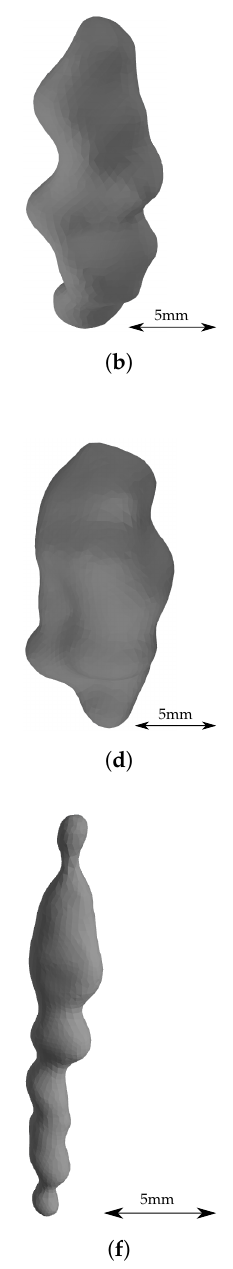
Figure A1. Investigated shrinkage porosities and corresponding artificial defects ( a ) CT: Specimen #31 ( b ) Numerically generated porosity: Specimen #31 ( c ) CT: Specimen #32 ( d ) Numerically generated porosity: Specimen #32 ( e ) CT: Specimen #34 ( f ) Numerically generated porosity: Specimen